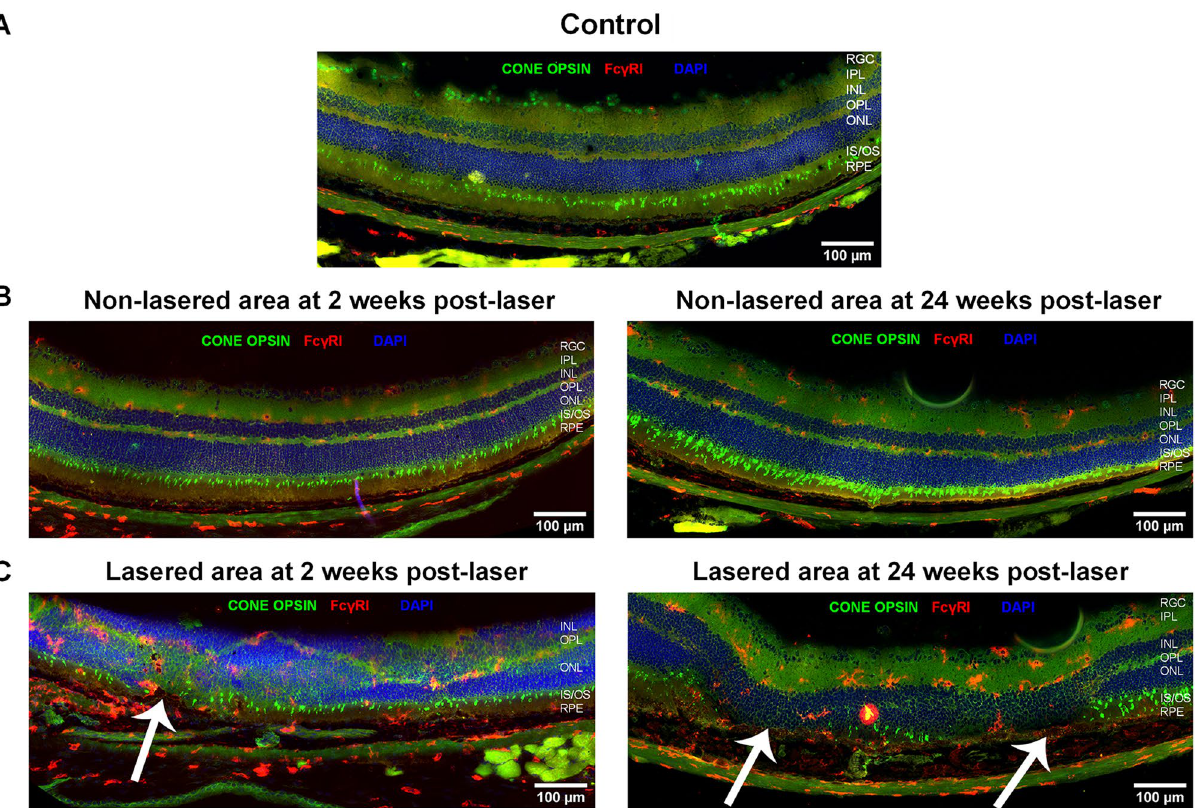
Figure 5. Increased presence of FCγRI + cells and cone photoreceptor damage after induction of RLCS. Representative immunofluorescence images of stained retinal sections from ( A ) naïve control mice; ( B ) non- lasered areas of retina and ( C ) corresponding laser spot areas at 2 weeks (left) and 24 weeks (right) after laser treatment to induce a RLCS. Retinal sections were probed with antibodies against cone opsin (green), anti- FcγRI (red) and DAPI nuclear stain (blue). Tissues show evidence of the absence of cone photoreceptors and increased FCγRI + cells at the lesion sites (white arrows). Retinal ganglion cell layer (RGC); inner plexiform layer (IPL), inner nuclear layer (INL), outer plexiform layer (OPL), outer nuclear layer (ONL), photoreceptor inner segment/outer segment junction (IS/OS), retinal pigment epithelium—Bruch’s membrane interface